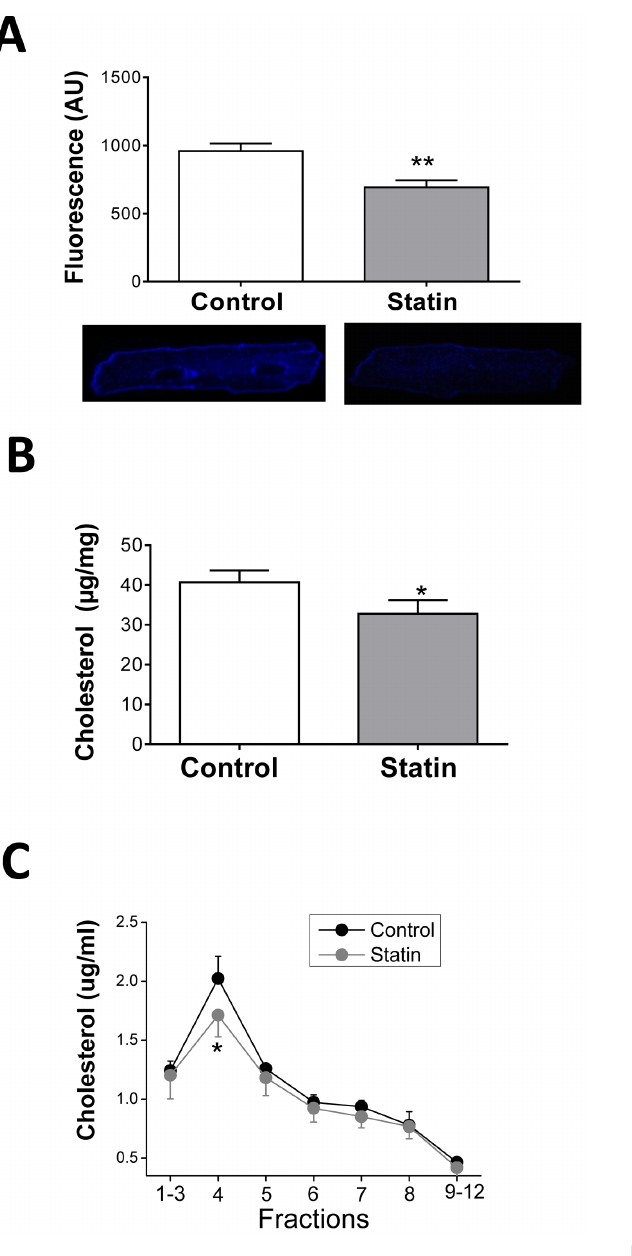
Figure 1. Treatment with 10 m M simvastatin for 48 h reduces cellular and caveolar cholesterol in the adult ventricular myocyte. A. Cellular free cholesterol indexed in fixed myocytes labelled with filipin. Bar graph shows mean fluorescence (arbitrary units, AU) from n=48-58 myocytes (from 4 hearts). Representative control and statin-treated myocytes are shown below. B. Total cholesterol (normalised to total protein concentration) measured in cell lysates using the Amplex Red assay (n=7 hearts). C. Cholesterol distribution measured in cell lysates following sucrose density gradient fractionation using the Amplex Red assay. Samples were adjusted to equal protein concentrations before fractionation (n=3 hearts). All data are mean 6 S.E.M. * P , 0.05, ** P , 0.01 vs. control, Student’s t-test.